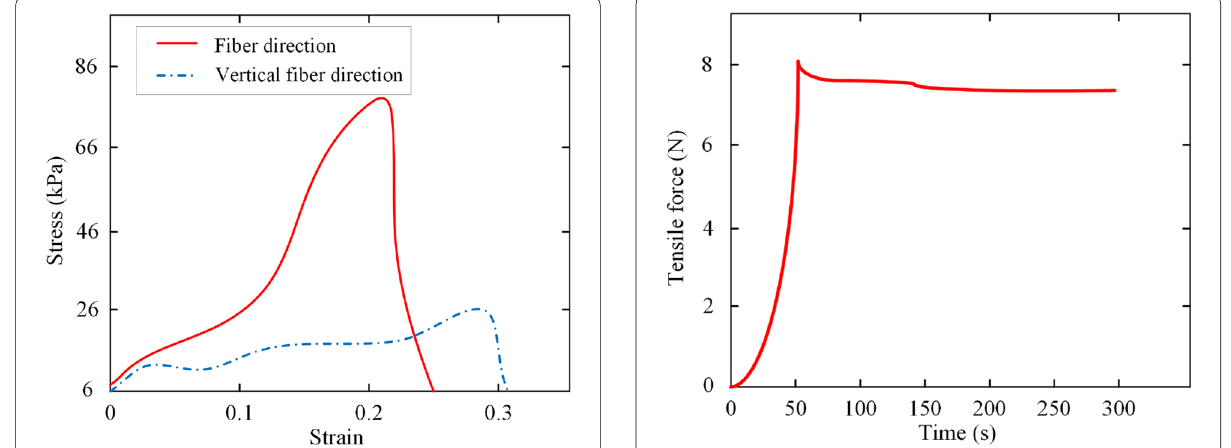
Figure 4 Tensile force time